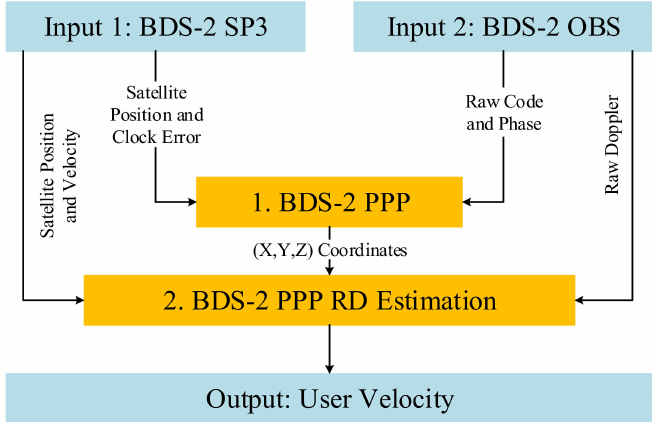
Figure 1. Flowchart of the proposed BeiDou Navigation Satellite System (BDS-2) precise point positioning (PPP) raw Doppler (RD) velocity estimation